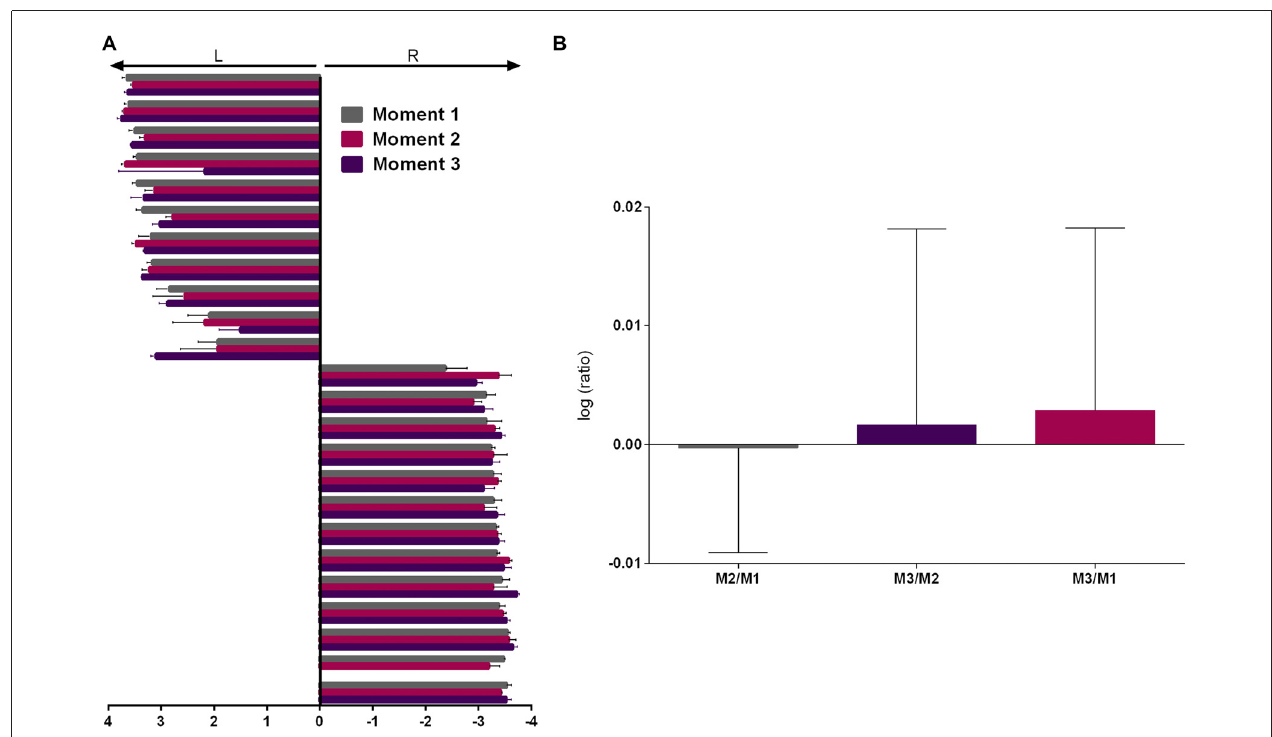
FIGURE 3 | PaTRaT time-related stability. Pawedness was evaluated at three separate moments. (A) Representation of the score attributed at each moment. 11/13 animals showed left/right preference, respectively. (B) Graph shows the logarithmic ratios between the three moments of evaluation. Data is shown as mean ± SEM. L, Left; R, Right; M, moment.